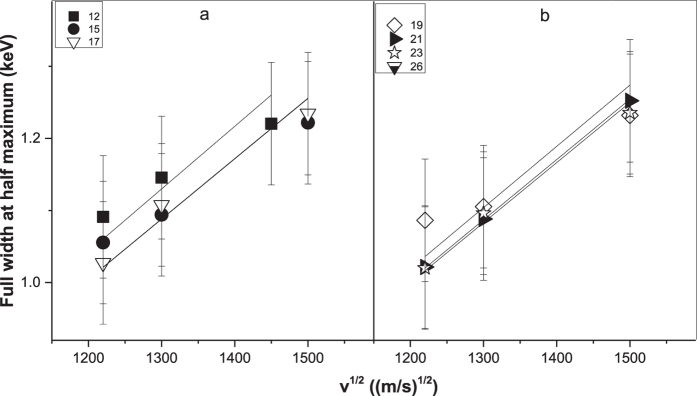
Full width at half maximum (FWHM) of the M band for Xe12, 15, 17+ (a) and Xe19, 21, 23, 26+ (b) vs v1/2. The solid lines represent the fitting results obtained using FWHM = kv1/2.